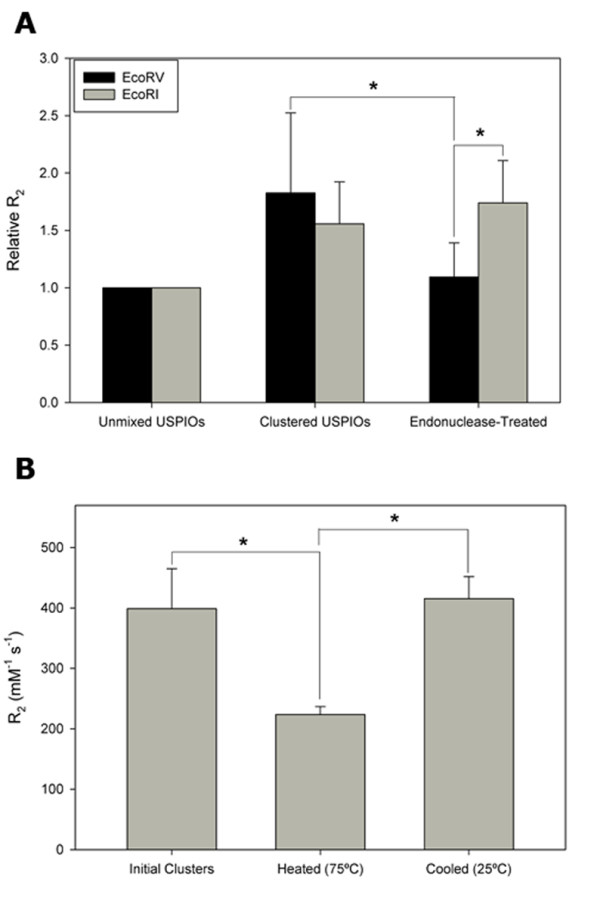
Controlled release of USPIO micelles by environmental triggers. (A) Self-assembly of EcoRV-sensitive ssDNA-USPIO clusters, and subsequent enzymatic treatment results in measurable changes in R2 relaxation coefficient relative to initial values. Following EcoRV treatment, R2 values return to baseline, a phenomenon that is in significant contrast to the effects of EcoRI treatment of the same clusters (n = 6). * p < 0.05. (B) Thermocycling of DNA-crosslinked USPIO clusters results in measurable changes in R2 relaxation coefficient. Heating of the clusters melts the DNA and results in declustering of the particles, corresponding to an approximately 50% decrease in R2 coefficient. After allowing the system to cool, the R2 coefficient increases to original levels, suggesting the reclustering of the ssDNA-USPIOs (n = 3). * p < 0.05.